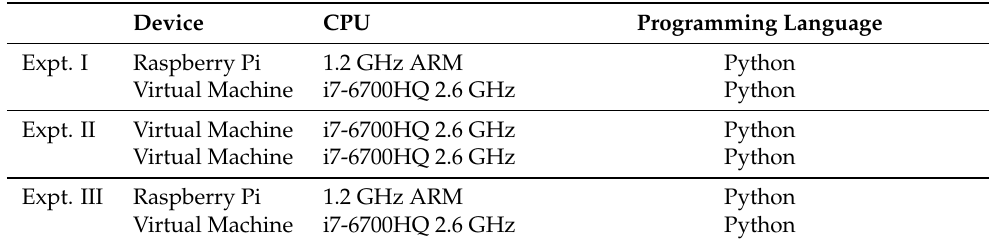
Table 4. Experimental setup.